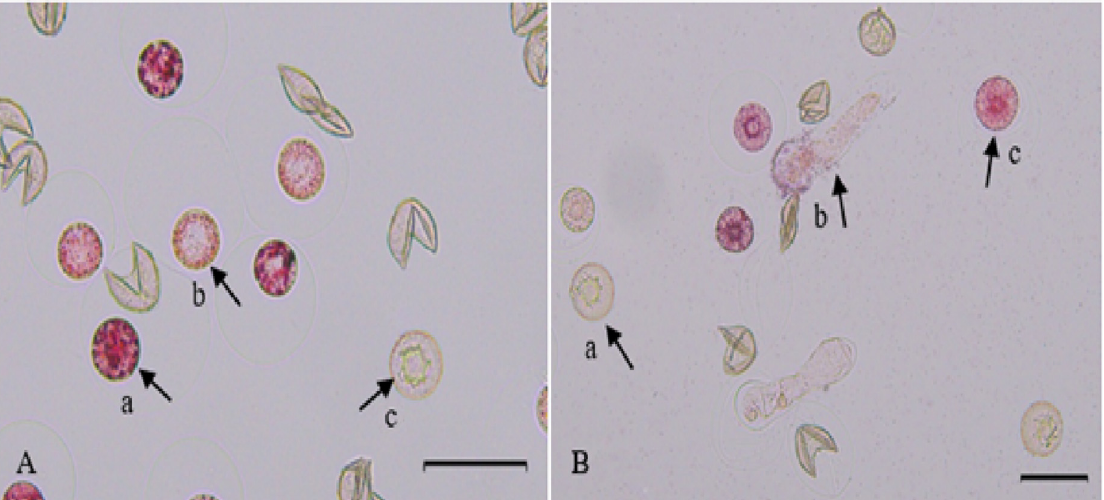
Figure 4. Pollen and pollen tubes of T. distichum var. distichum in TTC staining. ( A ) The staining of pollen grains showing pollen with strong viability ( arrow a), pollen with moderate viability ( arrow b) and the nonviable pollen ( arrow c). ( B ) The staining of pollen grains after in vitro cultivation showing that the nonviable pollen were not stained ( arrow a), the germinated pollen were stained red ( arrow b) and the stained pollen did not germinate ( arrow c). Bars: 50 µ m.